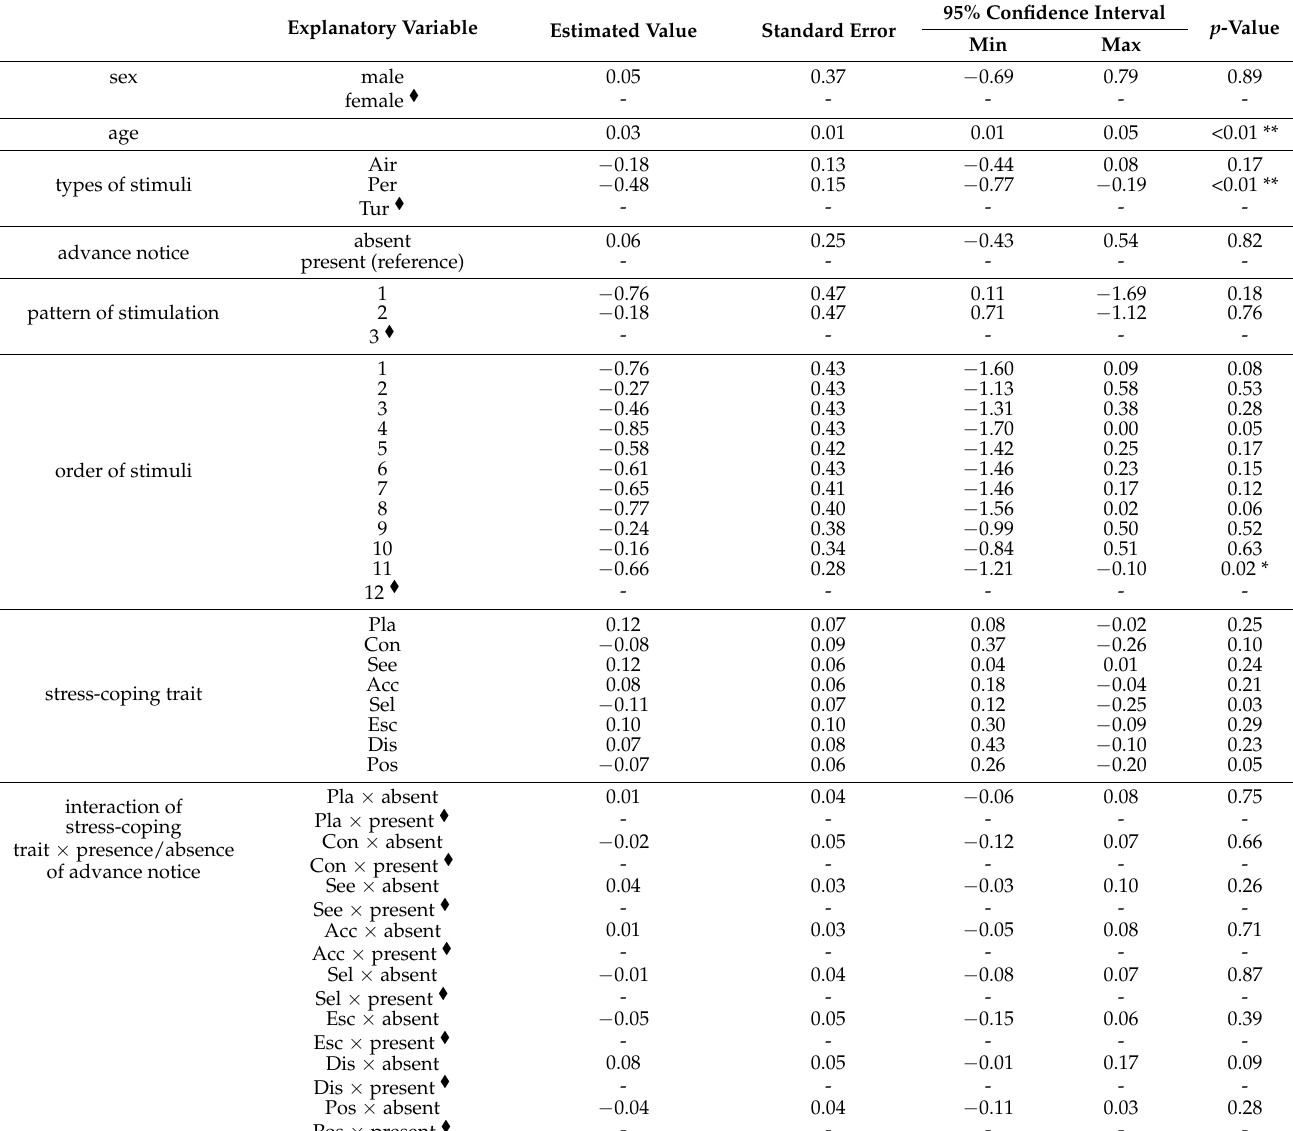
Table 3. The results of the analysis with SN including all the factors